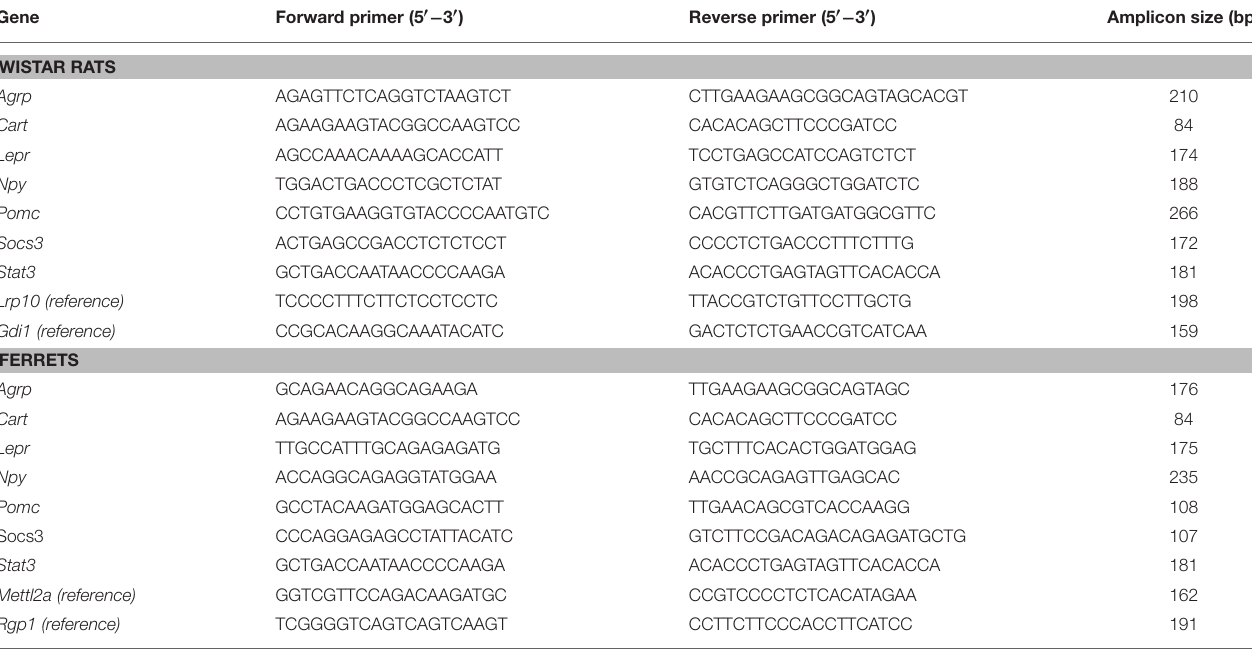
TABLE 1 | Nucleotide sequences of primers used for qRT-PCR amplification and size of the PCR products for rats and